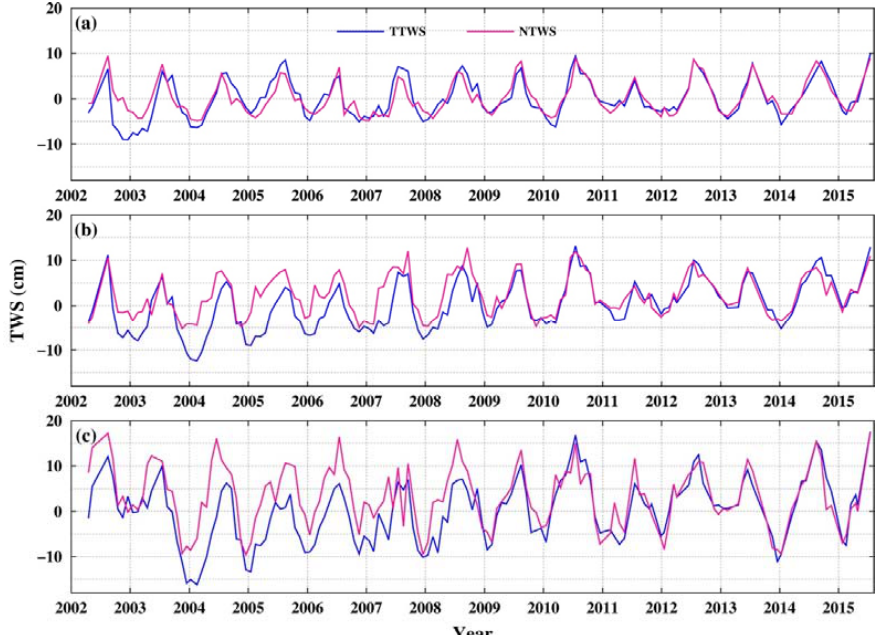
Figure 5. The natural ‐ driven terrestrial water storage (NTWS) and TTWS time series in the ( a ) upper, ( b ) middle, and ( c ) lower sub ‐ basins of the YRB. The red line and the blue lines represent the NTWS and TTWS time series, respectively. Notably, NTWS is predicted by natural data including precipitation, temperature, and soil moisture based on an artificial neural network (ANN) model and TTWS was calculated using GRACE data. Table 3. The area and the accuracy of the predicted NTWS in the three sub-basins of the